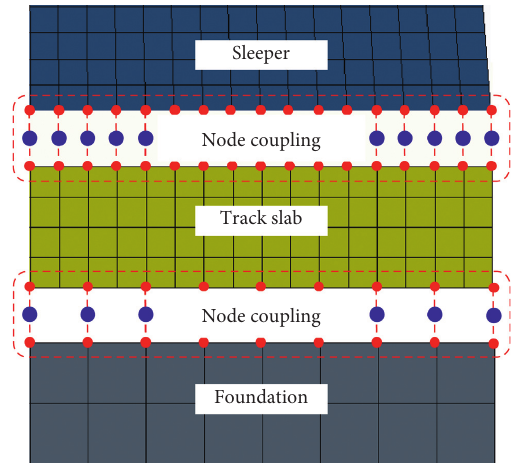
Figure 10: Node coupling technique applied at the interfaces.